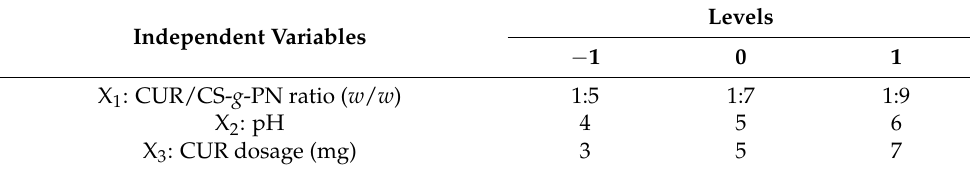
Table 1. Independent variables and levels of experimental